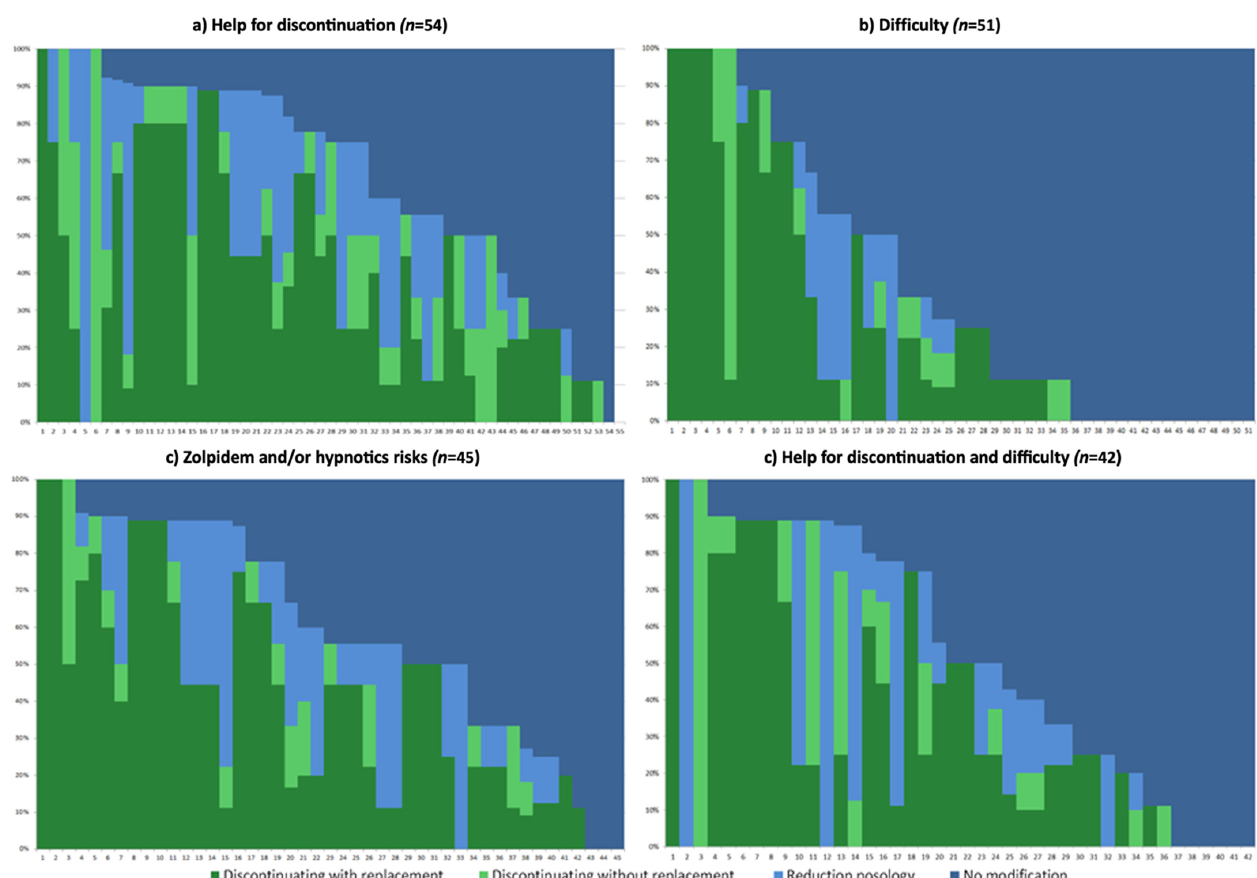
Figure 2. Percentages of population concerned by each strategy according to GPs’ answers to perception item. Legend: GPs are represented individually on x-axis (one vertical line represents one GP) and proportion of patients declared by GPs (are percentage) concerned by each strategy are represented on y-axis. For example, GP 3 of the Help for discontinuation group had applied the discontinuation with replacement strategy for 50% of his patients, where the discontinuation without replacement strategy had been applied for 50% of this GP patients. Table 2. Different proportions of patients concerned by each strategy and GPs’ characteristics ac- cording to their pattern of perception of the new regulation.